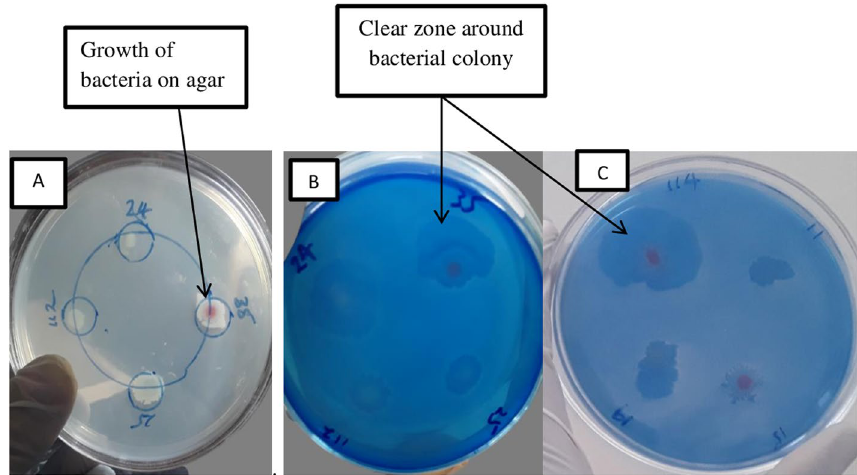
Fig. 2 Clear zone formed by isolates after 2 weeks incubation in mineral salt medium supplemented with 0.2% polyethylene glycol (“ A ” growth of bacteria on medium before staining with 0.1% Coomassie Brilliant Blue solution. “ B ” and “ C ” Clear zone around bacterial colony after staining with 0.1% Coomassie Brilliant Blue solution)